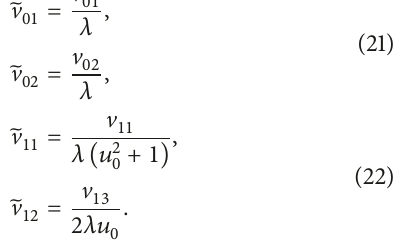
solving simultaneously 𝐷Φ 𝜆 (̃ k 0 ) = k 0 = ( V 01 , V 02 , 0) and ) = k = ( V , V , V ) with respect to ̃ V 𝐷Φ 𝜆 (̃ k 1 1 11 12 13